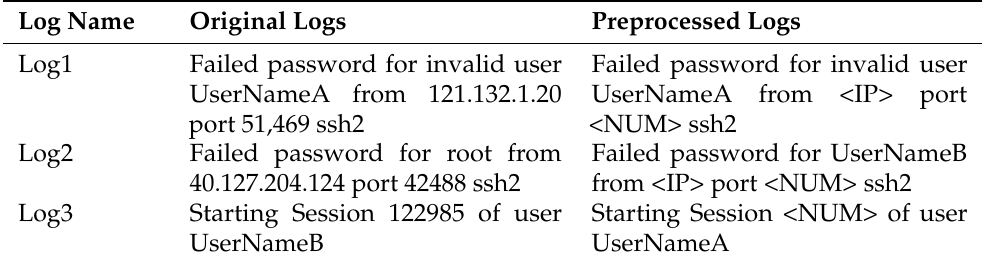
Table 1. The Example logs to be